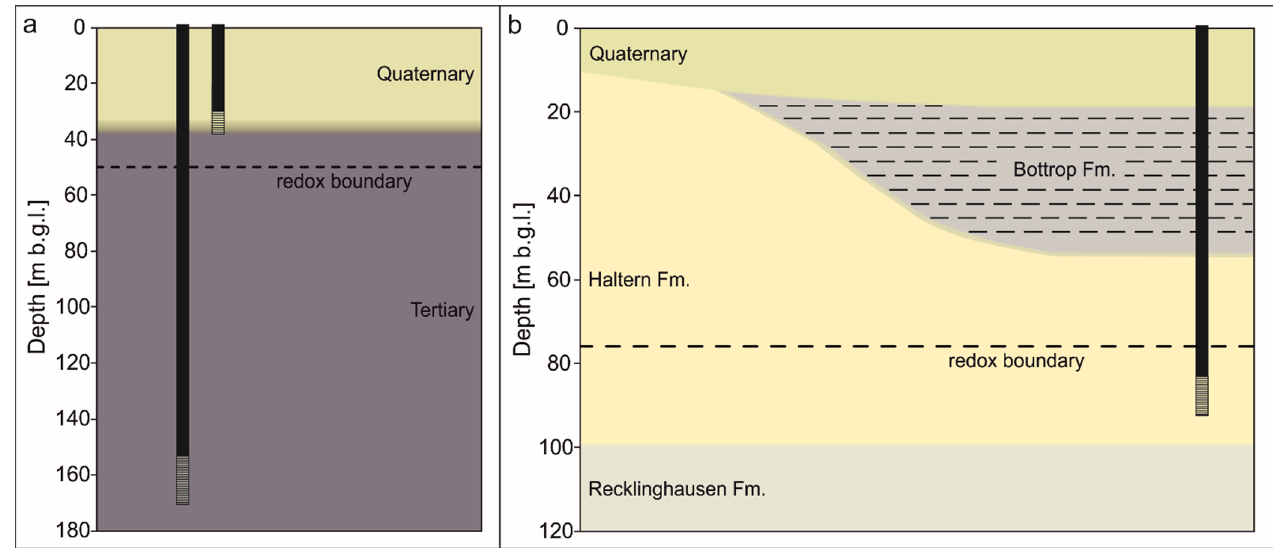
Figure 1. Schematic comparison of the 2 aquifers. ( a ) Quaternary–Tertiary aquifer with shallow and deeper production wells: The Quaternary and Tertiary are in direct hydraulic contact. ( b ) The Haltern Fm. aquifer with production wells, with the Bottrop Fm. as a protection layer.